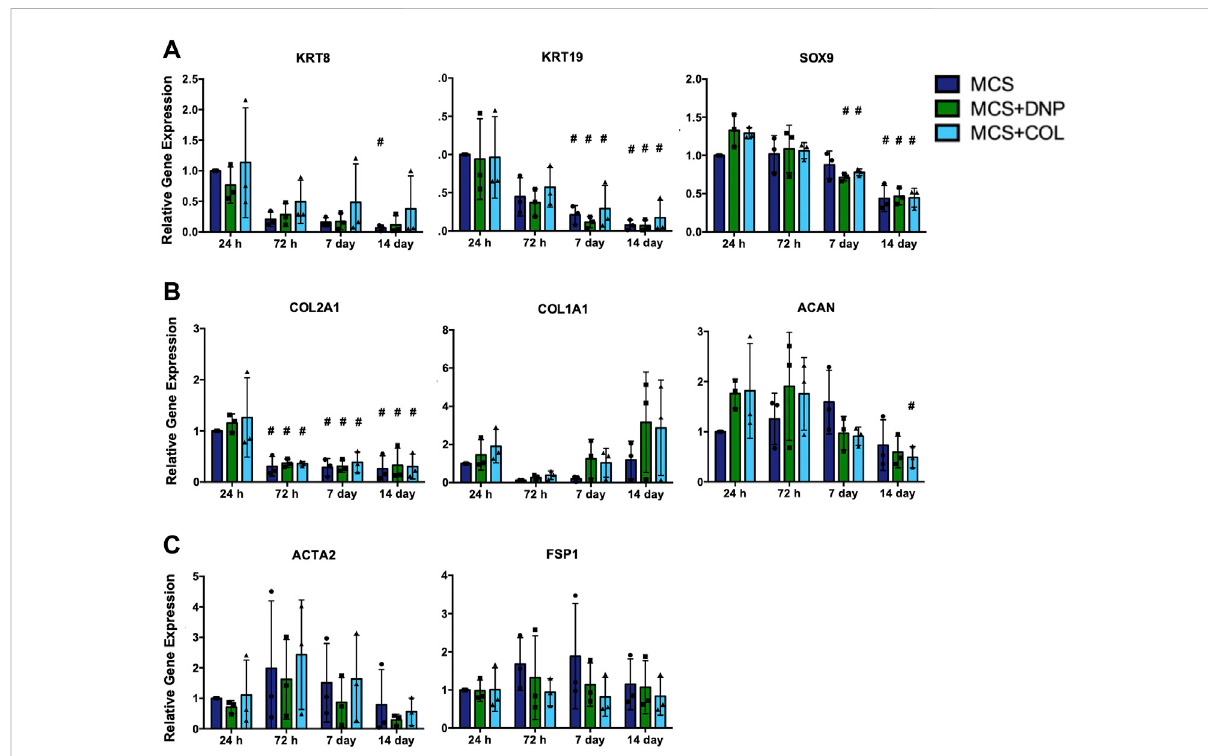
FIGURE 7 RT-qPCR gene expression analysis of primary bovine NP cells encapsulated within MCS ± DNP/COL scaffolds and cultured in vitro up to 14 days. Unpassaged (P0) primary bovine NP cells were encapsulated within MCS, MCS + DNP, or MCS + COL hydrogels, and cultured in vitro for 24 h, 72 h,7 days, or14 days.Geneexpression analysis was performedto quantifyexpressionof (A) NP-associatedmarkers ( KRT8,KRT19,SOX9 ), (B) ECM genes ( COL2A1, COL1A1, ACAN ), and (C) fi broblast markers ( ACTA2, FSP1 ). Relative gene expression was determined using the ΔΔ C t method normalized to expression of the housekeeping gene GAPDH , and expressed relative to cells encapsulated within MCS at 24 h. Data is presented as mean ± SD (N = 3, p < 0.05, * indicates signi fi cant difference between culture conditions, # indicates signi fi cant difference within each condition relative to 24